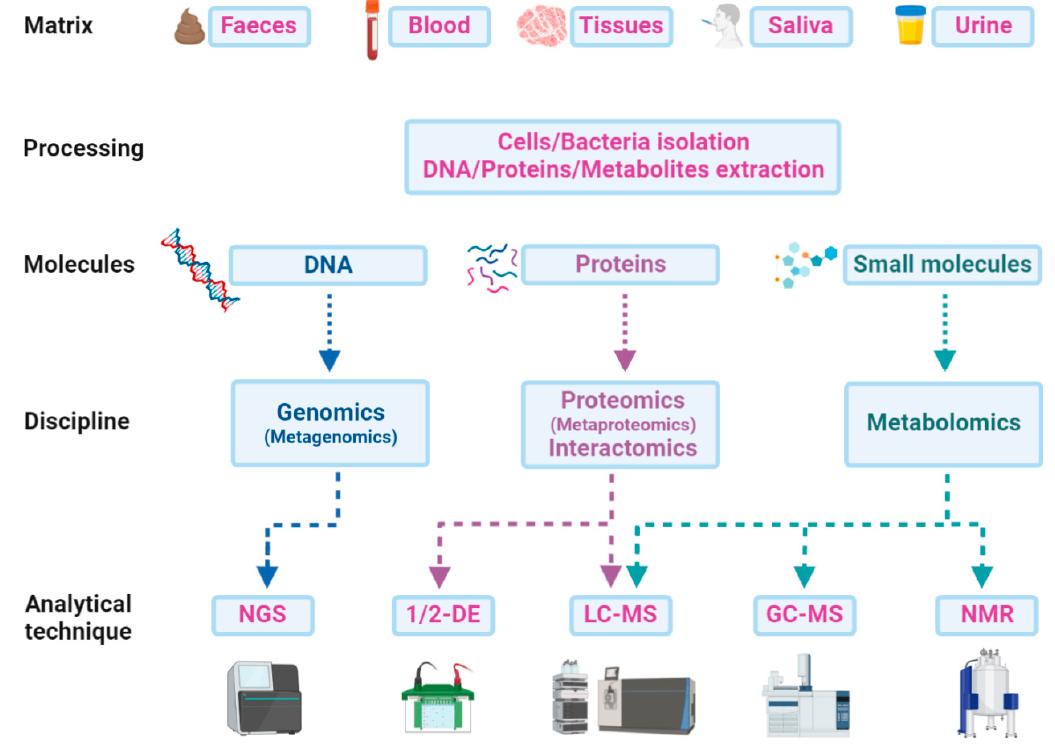
Figure 3. Scheme of the paths from matrices to analytical techniques in a multi-omics approach: An